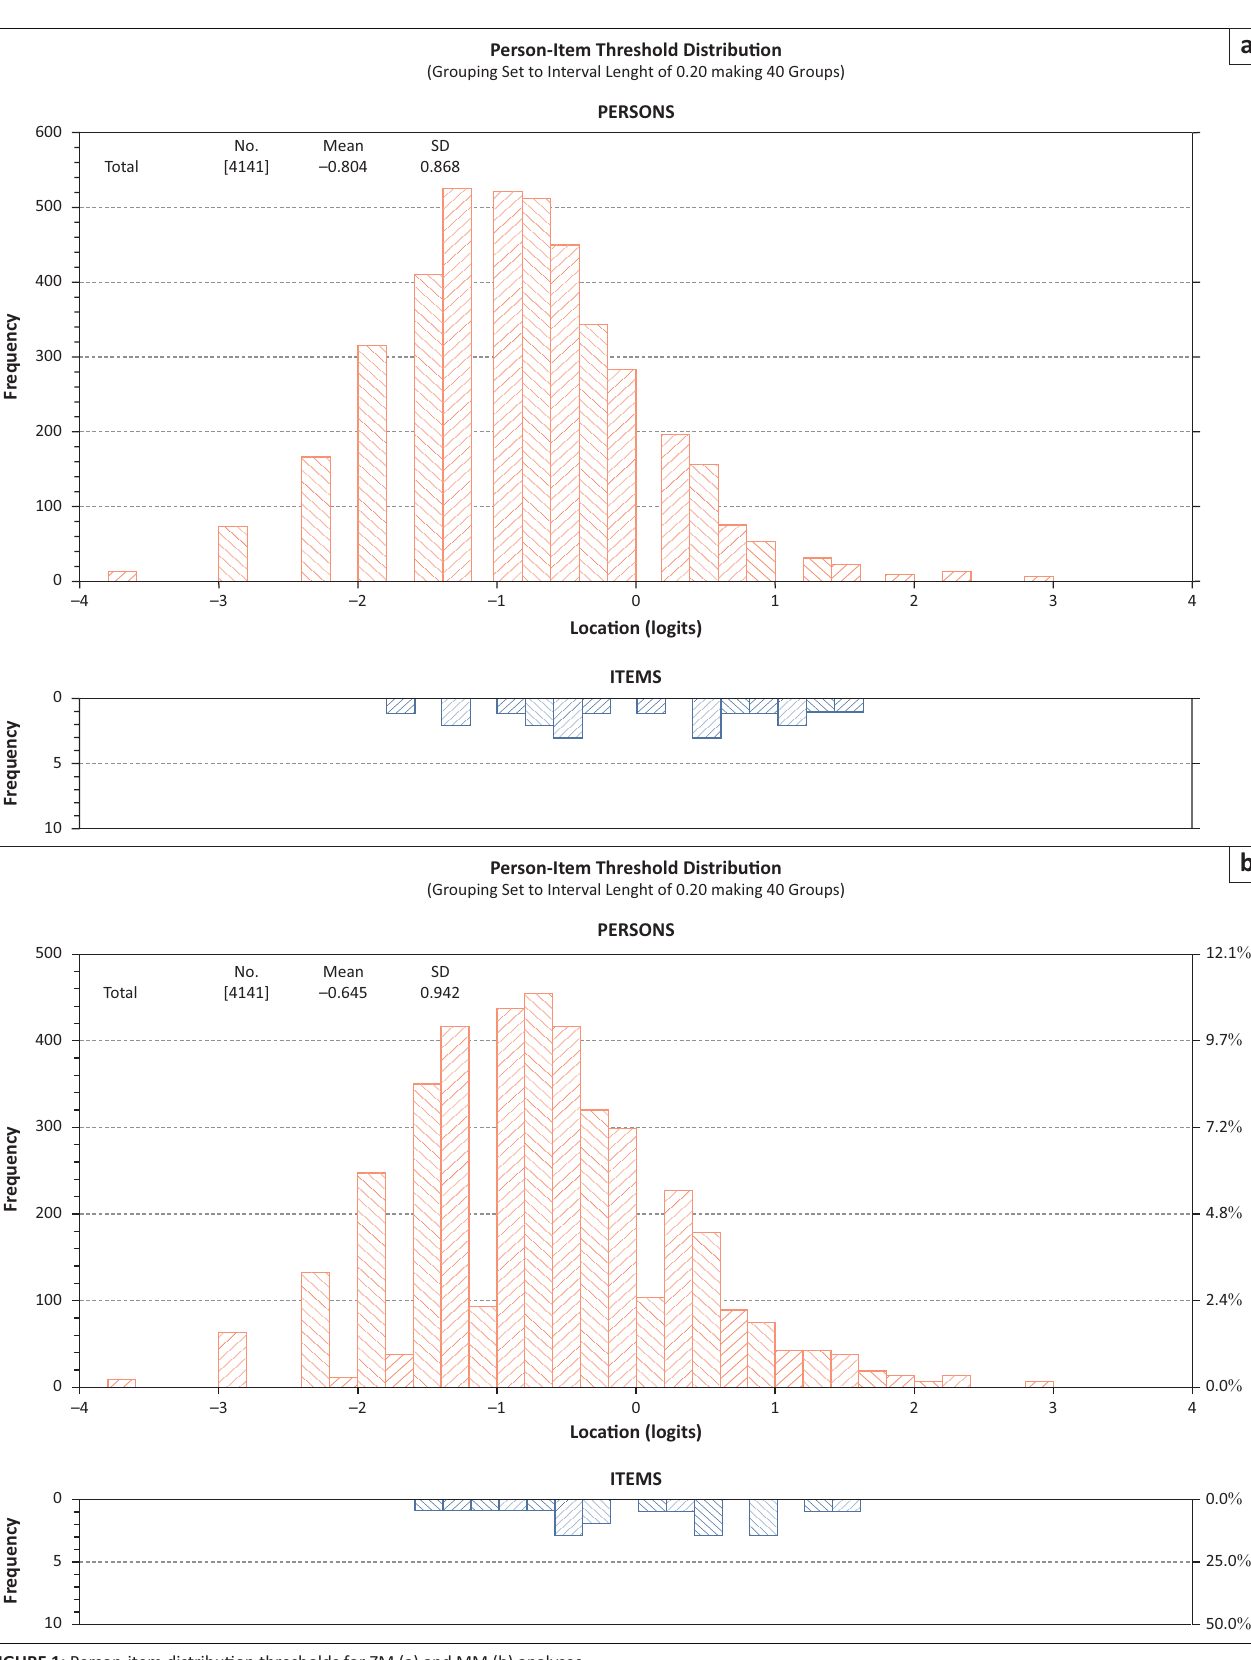
FIGURE 1: Person-item distribution thresholds for ZM (a) and MM (b)